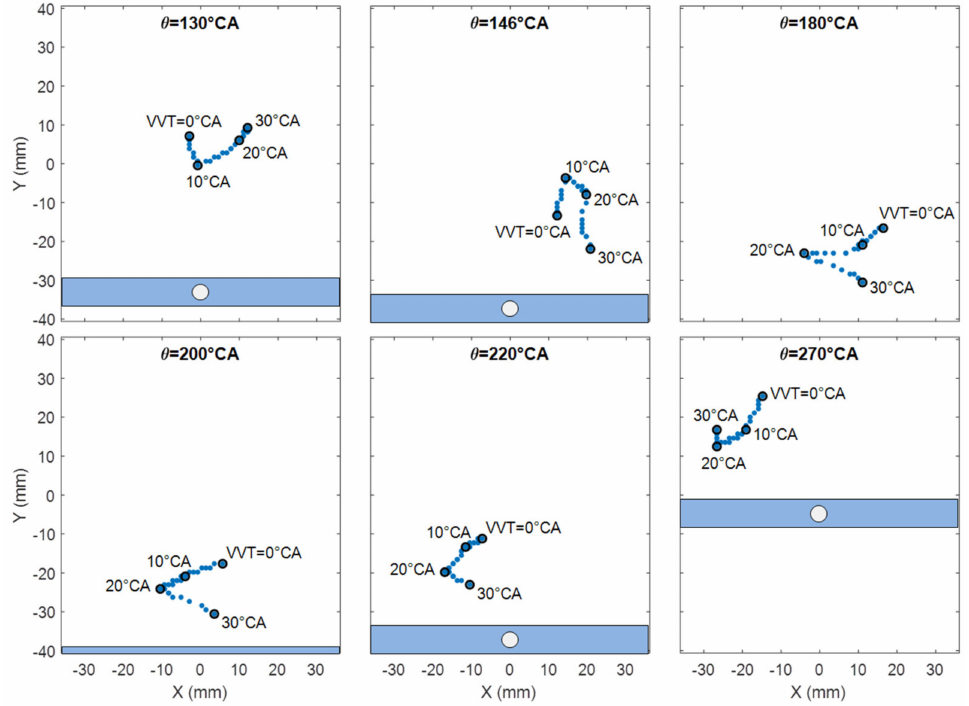
Figure 17. Evolution of the tumble center position with the VVT offset. As mentioned before, the intake valves are on the right. The valve jet followed the left wall of the cylinder, then the piston, and finally moved up along the right wall to form a rolling motion. In the middle of the intake phase, the strong VVT offsets were more intense. The rotational movements were driven by the valve jet, which pushed them to the opposite side, to the right of the cylinder. During the compression phase, the center distribution followed the same pattern. Low VVT offsets tended to be centered and away from the piston, while high offsets tended to be closer to the walls. The phenomenon became more pronounced for the angles 220 and 270 ◦ CA. The early closure of the intake valves made